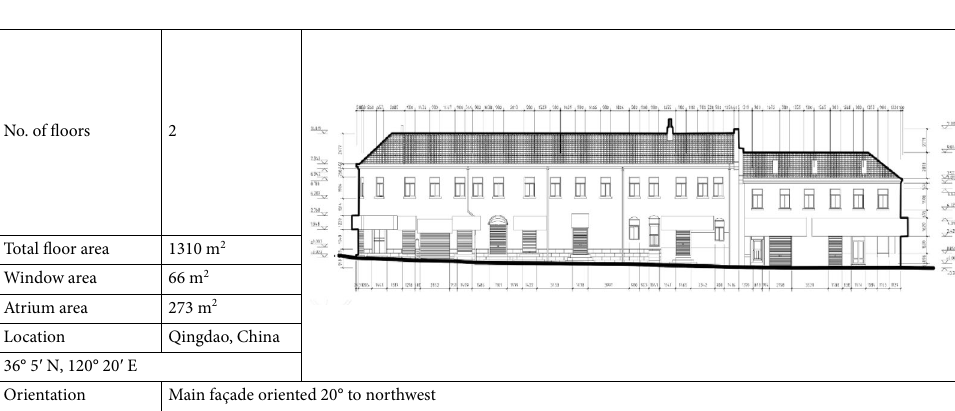
Table 1. The dimensional information of the